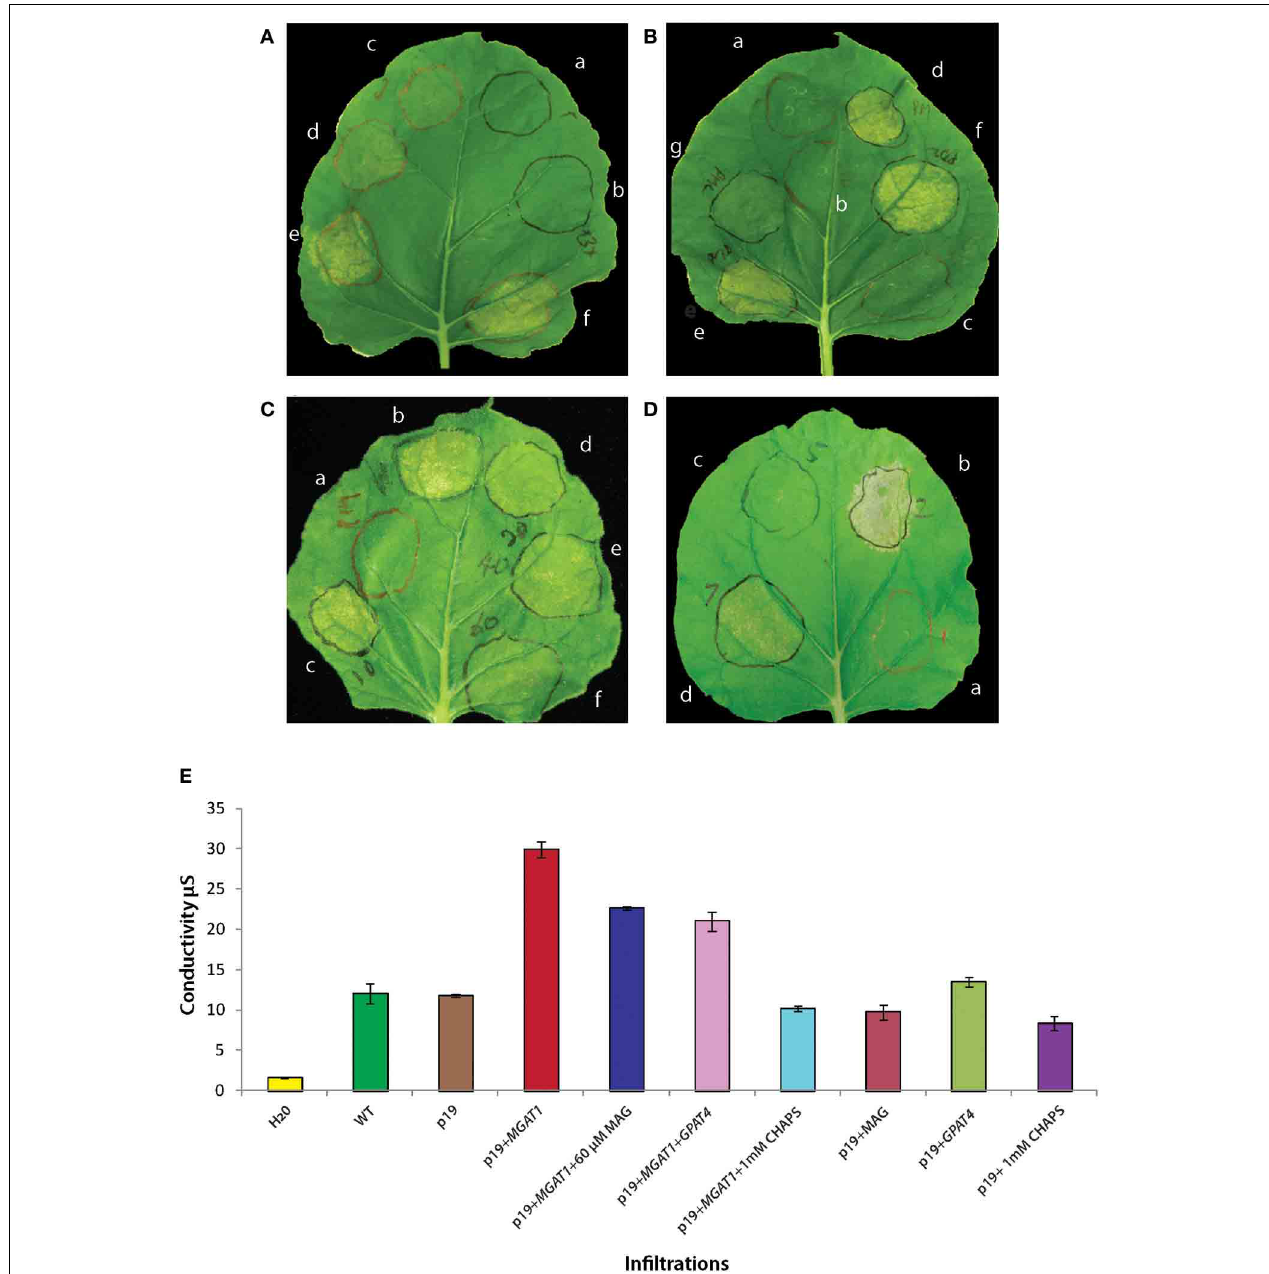
FIGURE 7 | Effect of MGAT1 expression and MAG depletion on observed senescence symptoms. (A) Leaf spots infiltrated with two different concentrations of p19 [OD 0.125 (Aa) and OD 0.375 (Ab) ] and four different concentrations of p19 + MGAT1 [0.03 OD (Ac) , 0.0625 OD (Ad) , 0.125 OD (Ae) and 0.25 OD (Af) ]. The severity of visible symptoms is correlated to MGAT1 concentration. (B) Co-infiltration of CHAPS or diacylglycerol acyltransferase ( DGAT1 ) with MGAT1 . No senescence symptoms are detected in the control treatments—p19 (a) , p19 + 1mM CHAPS (b) and p19 + DGAT1 (c) . Senescence induced by MGAT1 (d) is abolished by including 1mM CHAPS in infiltration mix containing MGAT1 (g) . No effect was observed when DGAT1 was co-infiltrated [0.125 OD (e) and 0.25 OD (f) ]. (C) MAG supplementation: 2-Oleoylglycerol was added to the infiltration